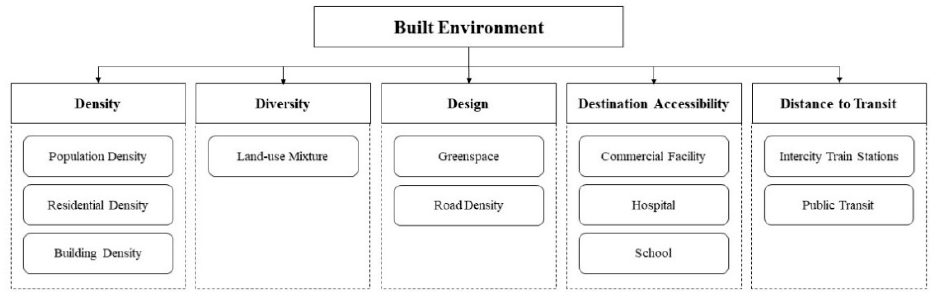
Figure 2. The framework of built environment metrics in current